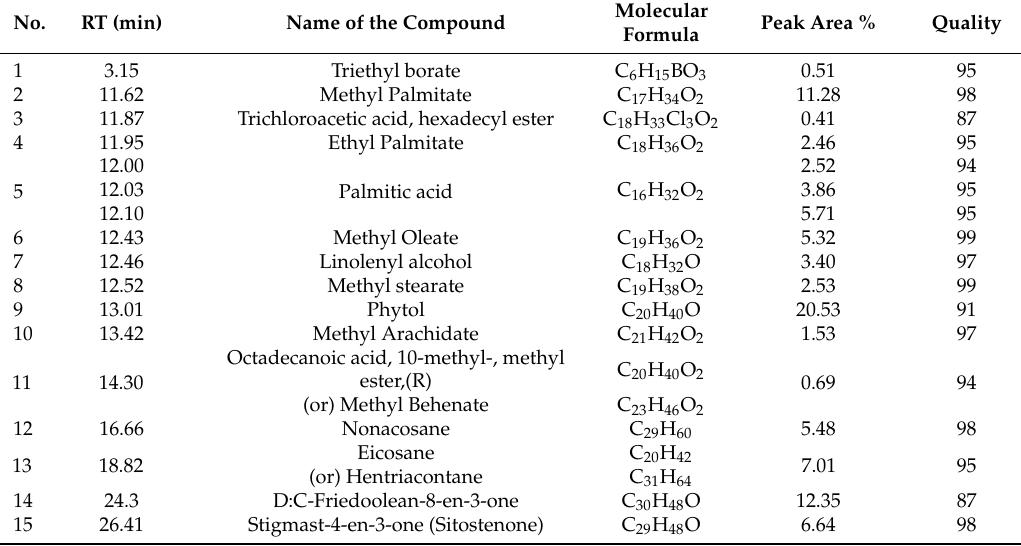
Table 5. GC-MS spectral analysis of ethanolic extract of Gongronema latifolium